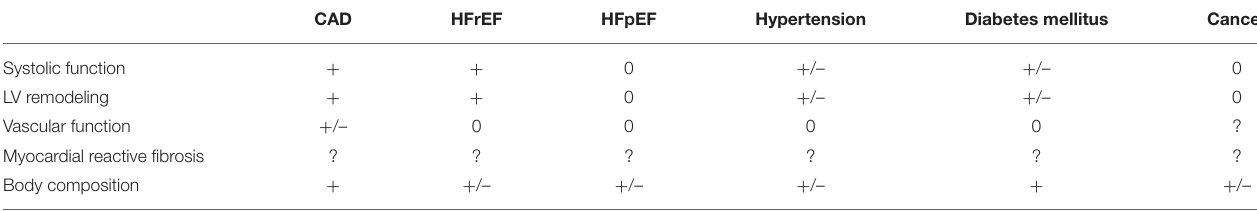
TABLE 4 | Overview of the exercise training effects of on cardiovascular imaging metrics in patients with or at risk for cardiovascular disease. CAD HFrEF HFpEF Hypertension Diabetes mellitus